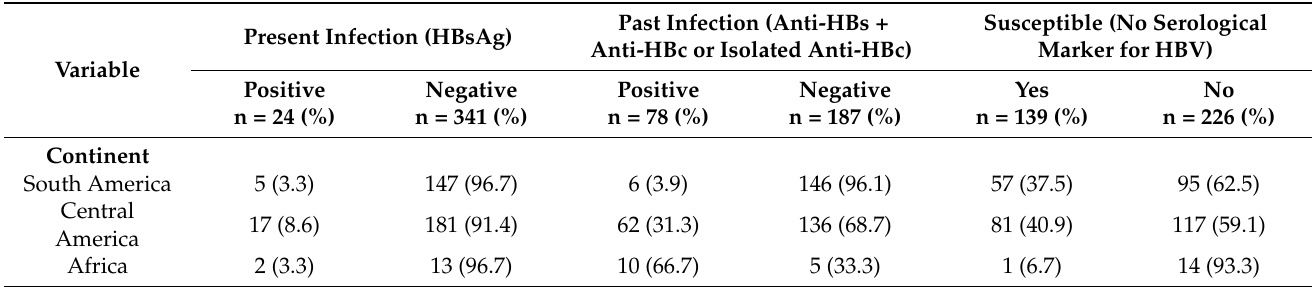
Table 2. Data on current infections, past infections, and susceptibility considering the continent of origin of 365 immigrants and refugees from the State of Goi á s, Brazil,